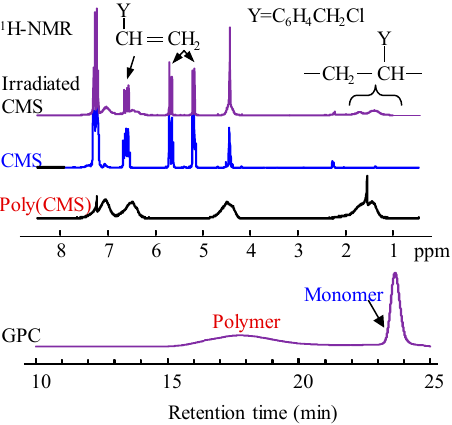
Figure 1. NMR spectra for irradiated CMS monomer, new CMS monomer and commercial poly(CMS), and GPC curve for the irradiated CMS monomer. The irradiated CMS monomer solution was obtained from the grafting system irradiated with a total dose of 50 kGy at a dose rate of 1.0 kGy/h.